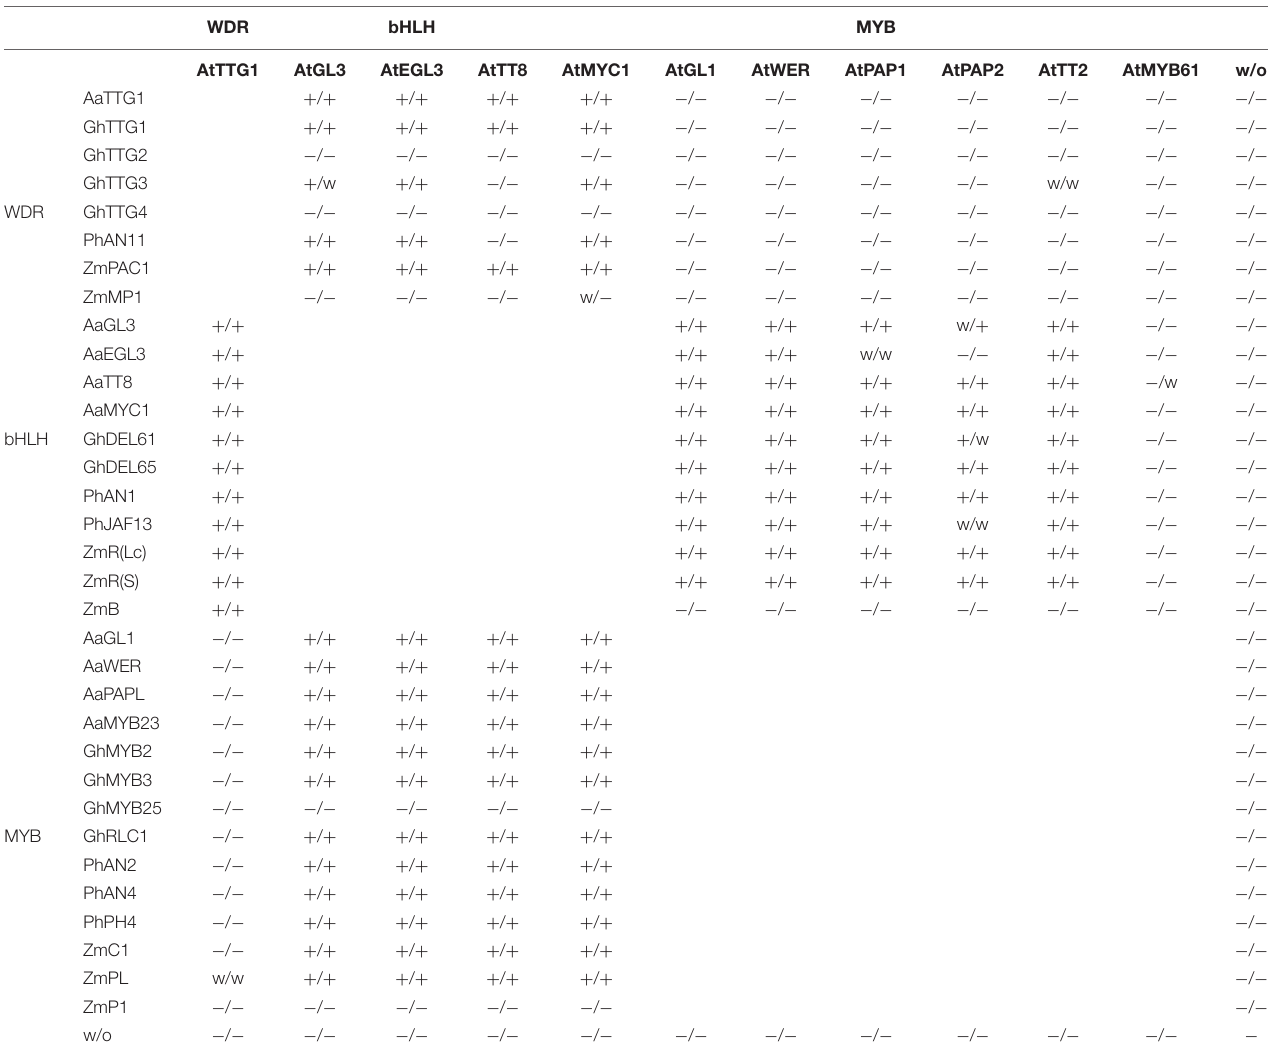
TABLE 5 | Analysis of inter-species MBW pairwise interaction by LUMIER pulldown